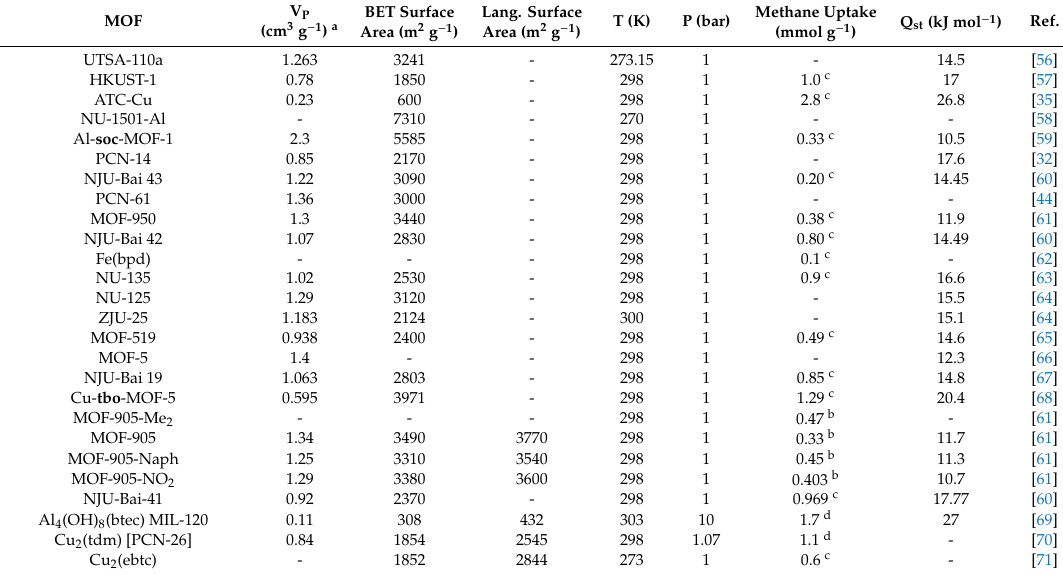
Table 1. Pore volume, BET surface area, Q st , and methane uptake of selected metal-organic frameworks